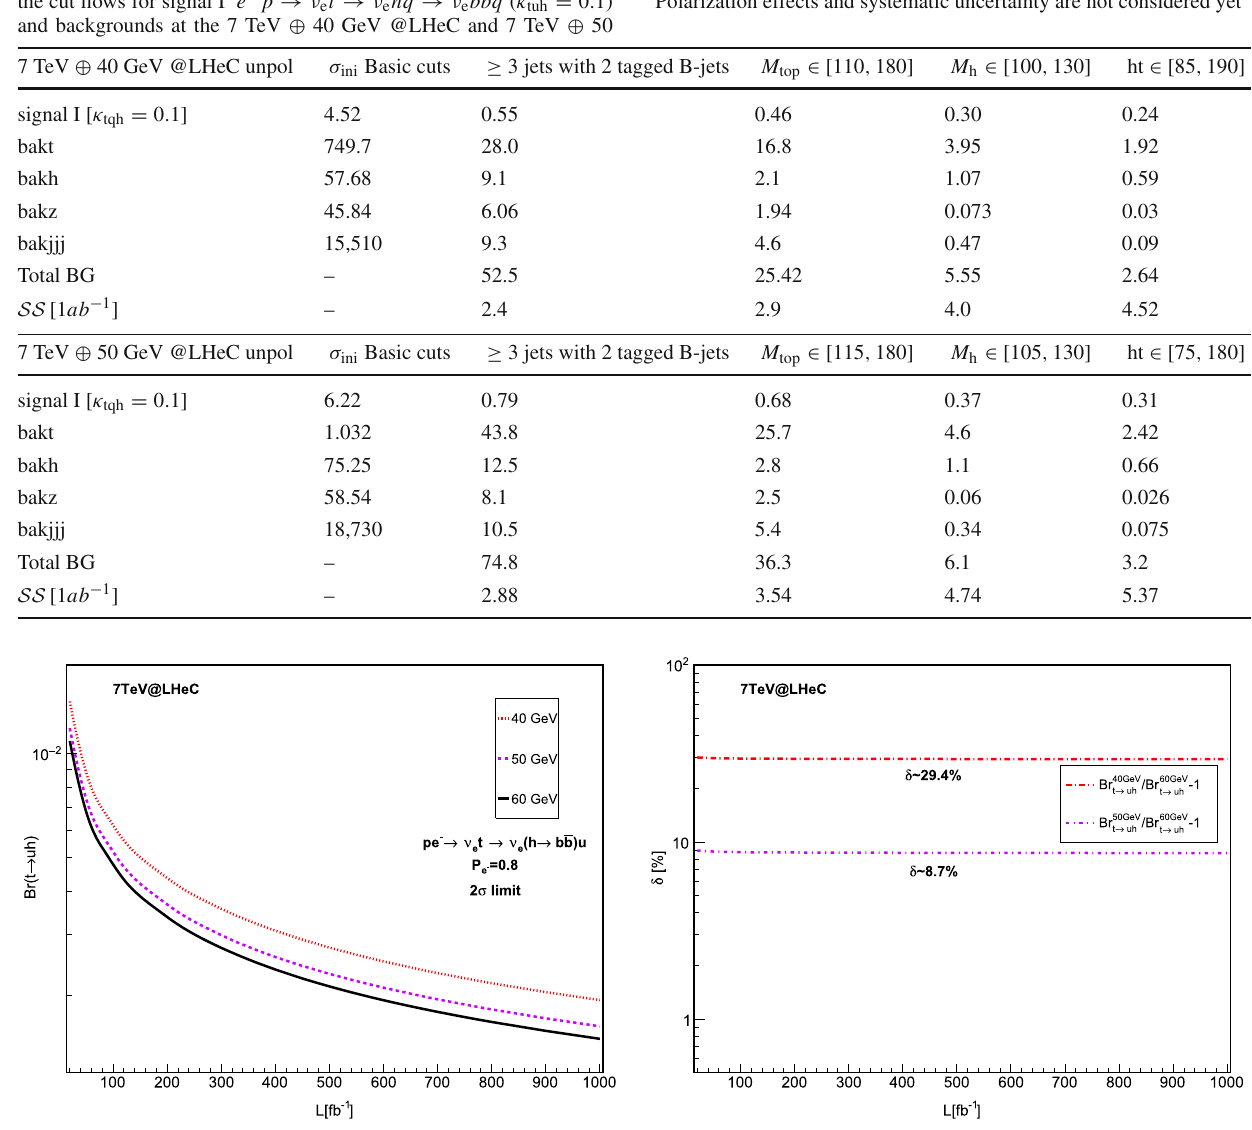
GeV @FCC-eh. SS is evaluated with 1 ab − 1 integrated luminosity.